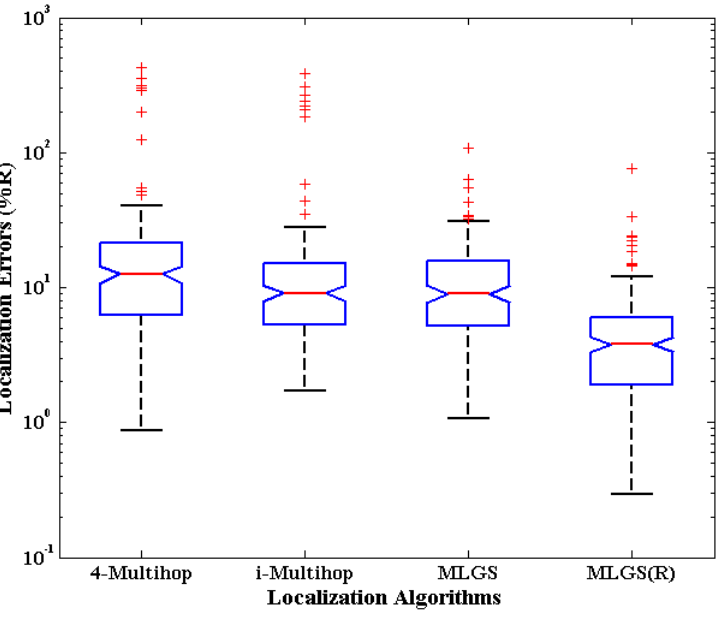
Figure 11. Distribution boxplots of node localization errors (anisotropic